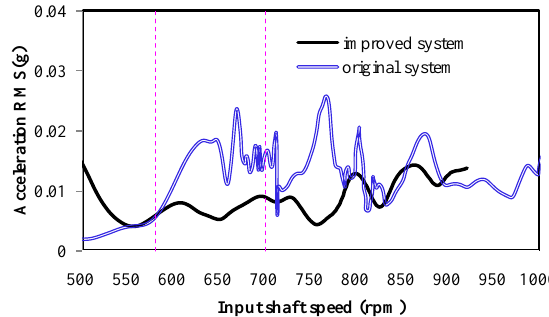
Figure 11. A vibration comparison of the cab seat at an order of 1.22.